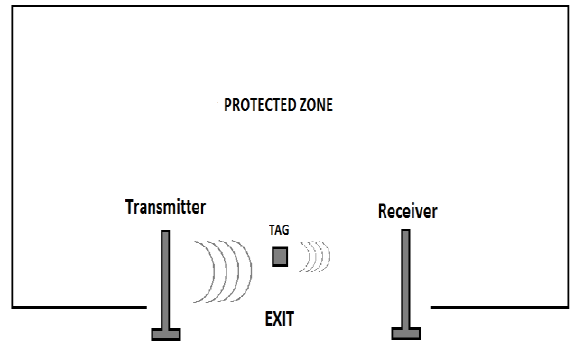
Fig. 1. Electronic Article Surveillance.